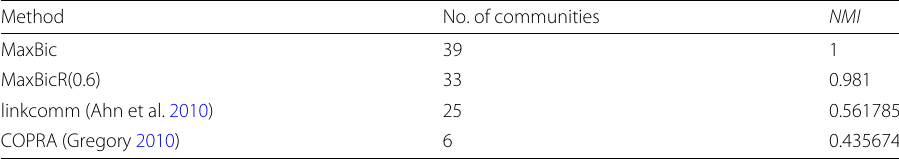
Table 6 Comparison of community numbers and NMI for Noordin Top terrorist network Method No. of communities NMI